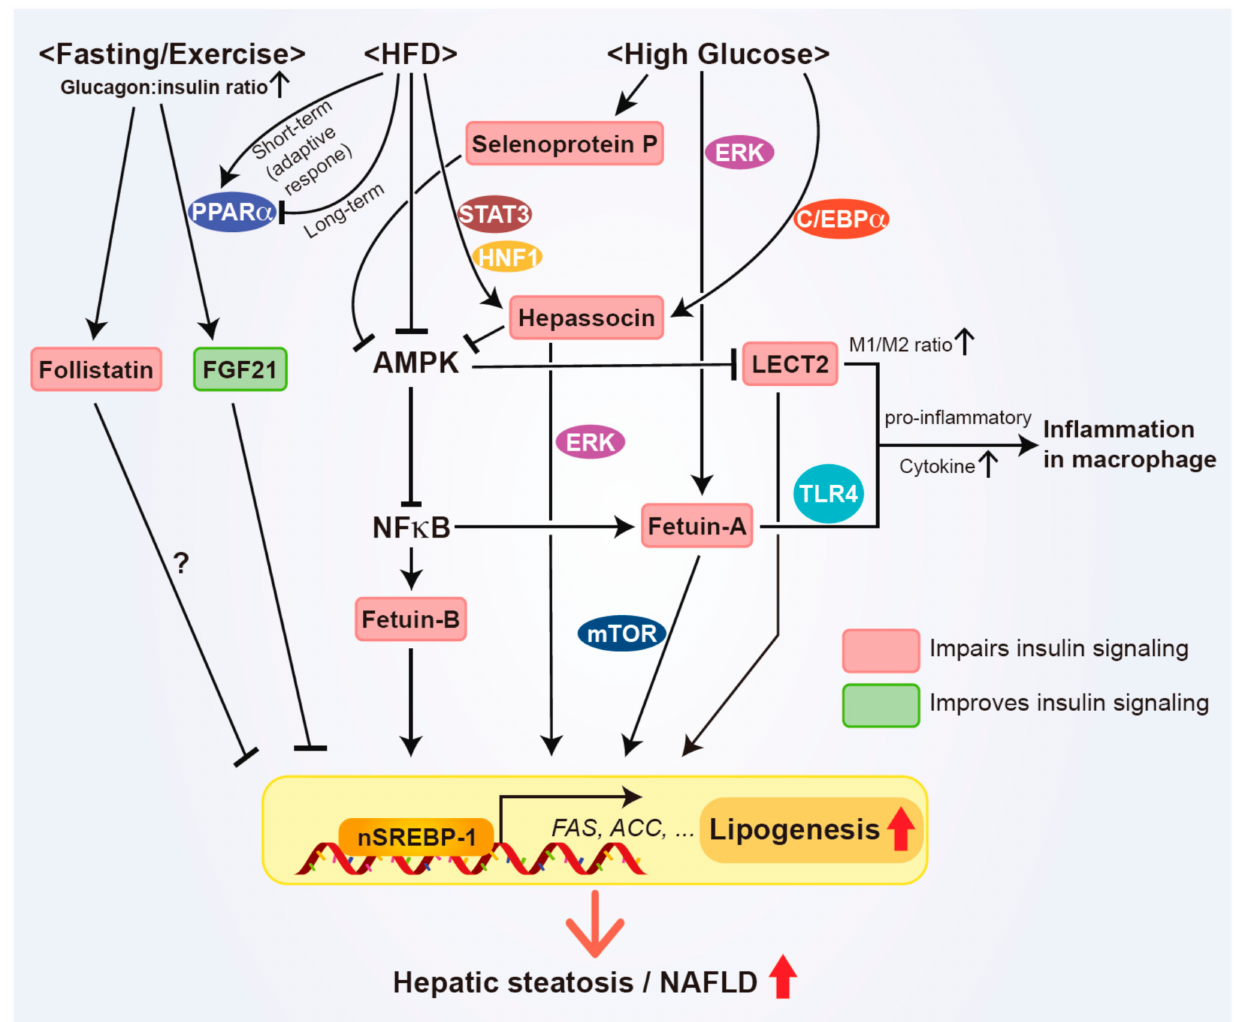
Figure 2. The impact of hepatokines on NAFLD progression and their associated signaling pathways. Most of the hepatokine expression is upregulated under HFD feeding and/or hyperglycemia. FGF21 has been reported to decrease or increase under HFD feeding. Hepatokines, except for FGF21, impair insulin signaling in hepatocytes, as well as non-hepatic tissues in an endocrine manner, with Fetuin-A and LECT2 promoting the macrophage inflammatory response by upregulating pro-inflammatory cytokine production. Fetuins, LECT2, and Hepassocin promote hepatic steatosis via the upregulation of lipogenic genes, whereas FGF21 suppressed it. The regulatory mechanism of follistatin on lipogenesis is